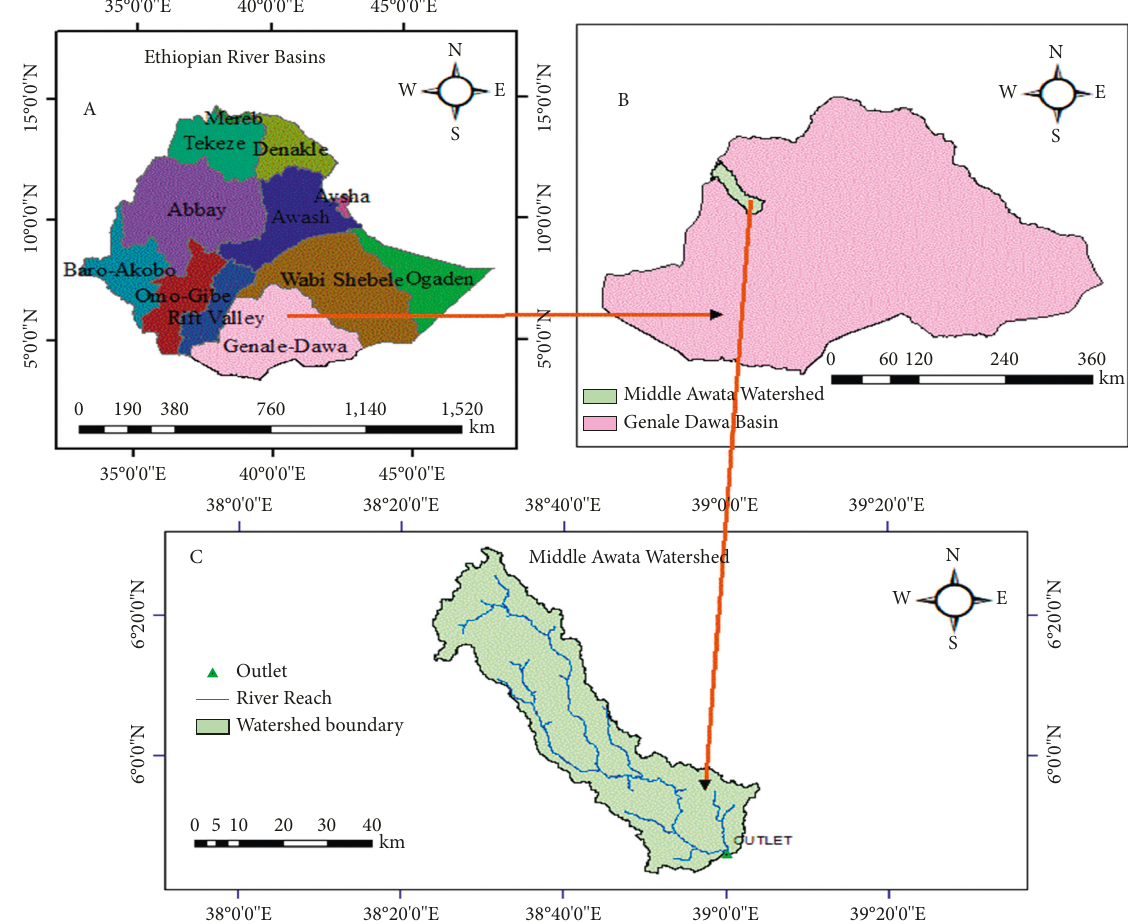
Figure 1: Location and map of the study area.